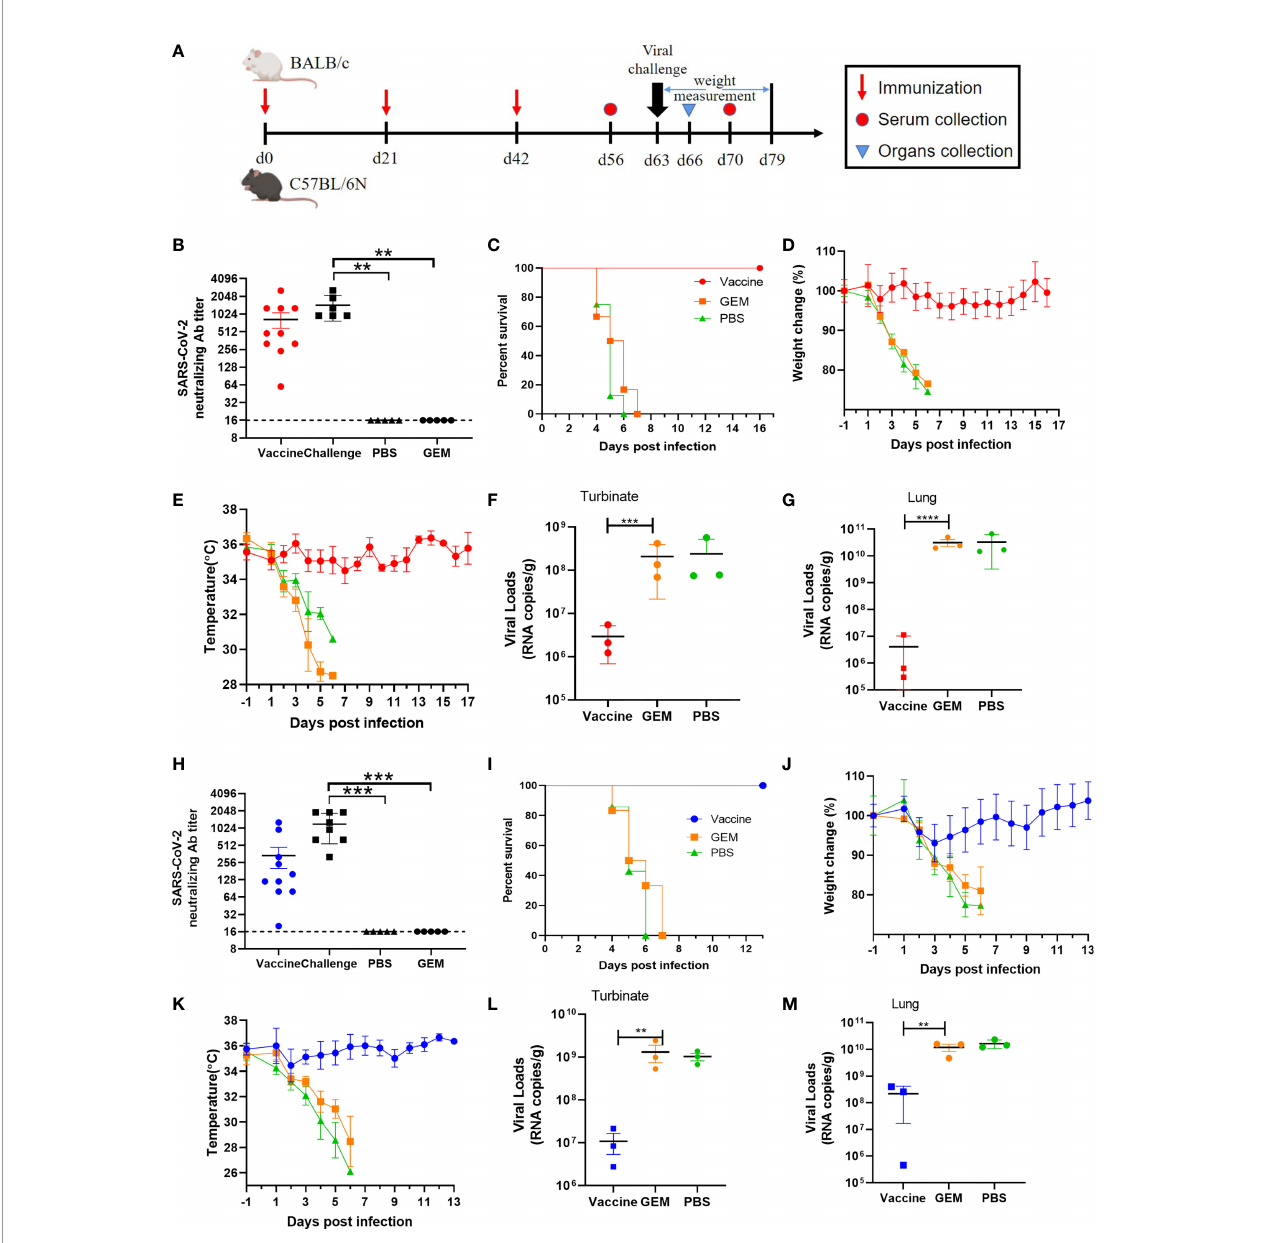
FIGURE 7 | Protection ef fi cacy of the severe acute respiratory syndrome 2 (SARS-CoV-2) bacterium-like particle (BLP) vaccine candidate against BMA8 and C57MA14 infection in aged mice. The vaccination schedule, viral challenge, and characterization of immunologic responses in aged BALB/c and C57BL/6N mice (A) . Groups of 9- month-old female BALB/c (n = 10) or C57BL/6N mice (n = 10) were immunized with three doses of 10 µg/dose BLP combined with Freund ’ s incomplete Freund ’ s adjuvant (IFA) in 3-week intervals. Empty Gram-positive enhancer matrix (GEM) vector or PBS with same adjuvant was given as negative controls. Serum was harvested at 2 weeks after the last immunization and at 1 week after SARS-CoV-2 challenge to detect the viral neutralizing antibody (B, H) . Mice were challenged with 50 LD50 of SARS-CoV-2 BMA8 or C57MA14 via i.n. route at 21 days after the third immunization. The survival rate (C, I) , weight change (D, J) , and body temperature (E, K) in each group were monitored daily after BMA8 or C57MA14 challenge. At 3 dpi, three mice in each group were euthanized, and turbinates (F, L) and lungs (G, M) were sampled for viral RNA loads by qRT-PCR. Data are presented as mean ± SEM. **P < 0.01, ***P < 0.001, ****P <